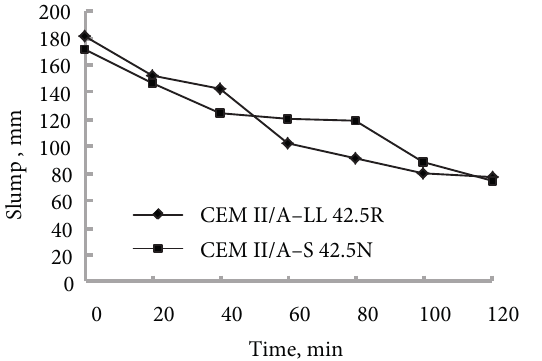
Fig. 3. A concrete mixture with different types of Portland cement and dependence of the superplasticizer having the plasticity of 1.25% on time at a temperature of +20